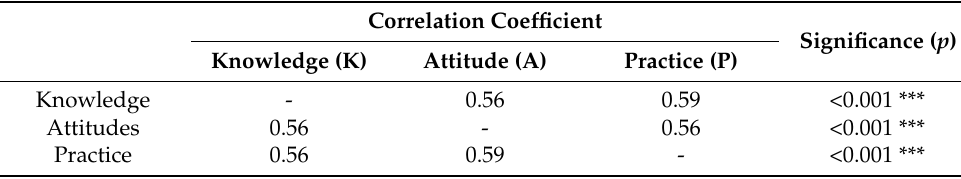
Table 2. Correlations among KAP components towards CRC and its screening ( n = 300).